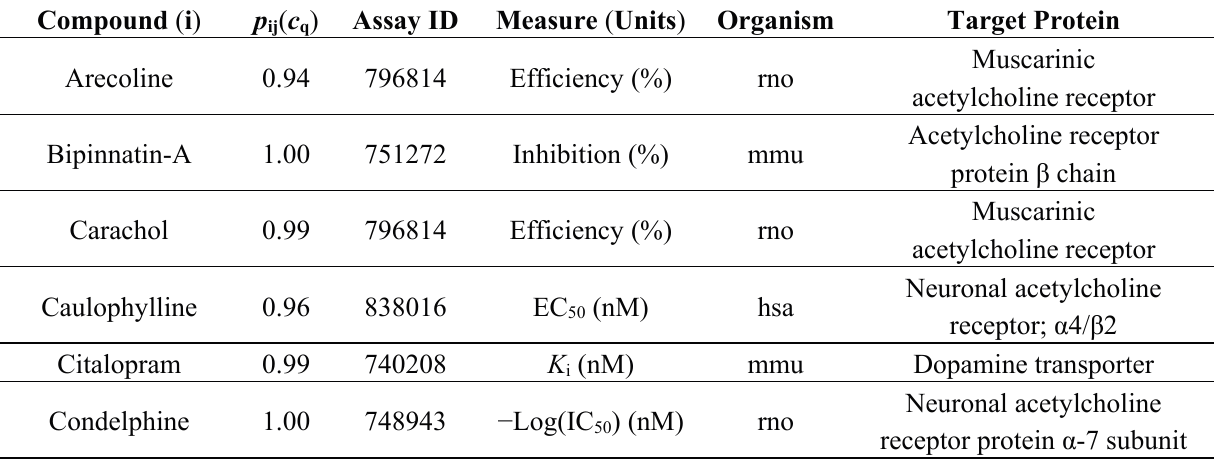
Table 2. Examples predicted with the